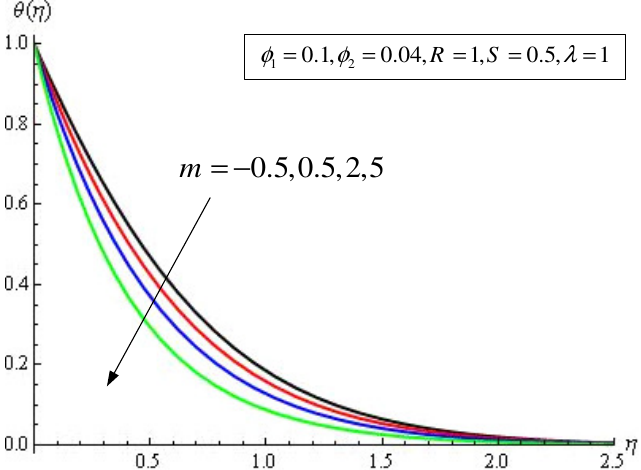
Figure 6. Impact of m on the temperature distributions of the hybrid nanofluid.